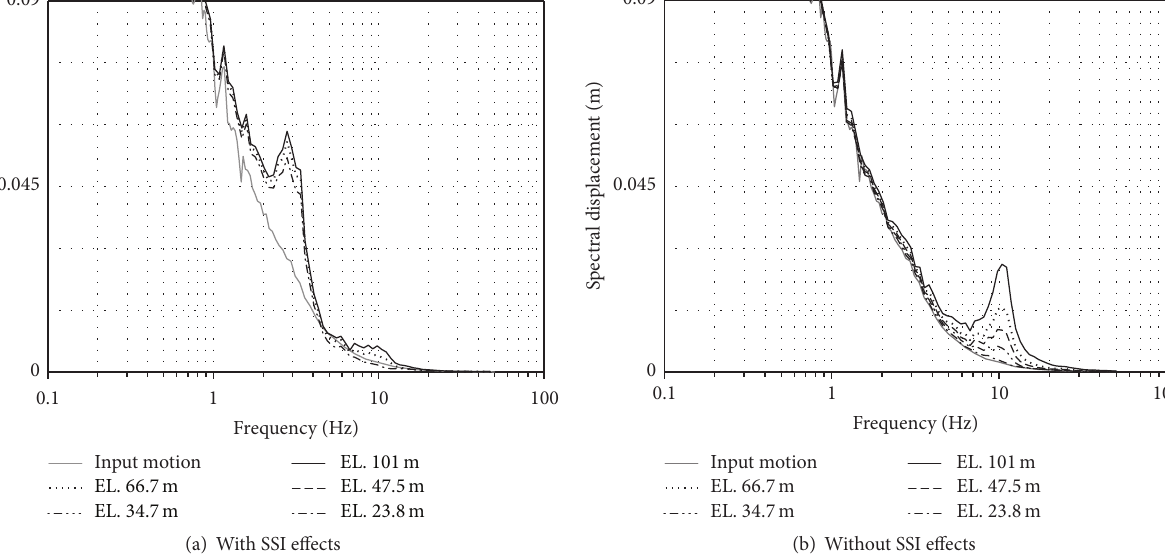
Figure 19: The response spectral displacement for different elevations of the Reactor Containment Building and vertical motion